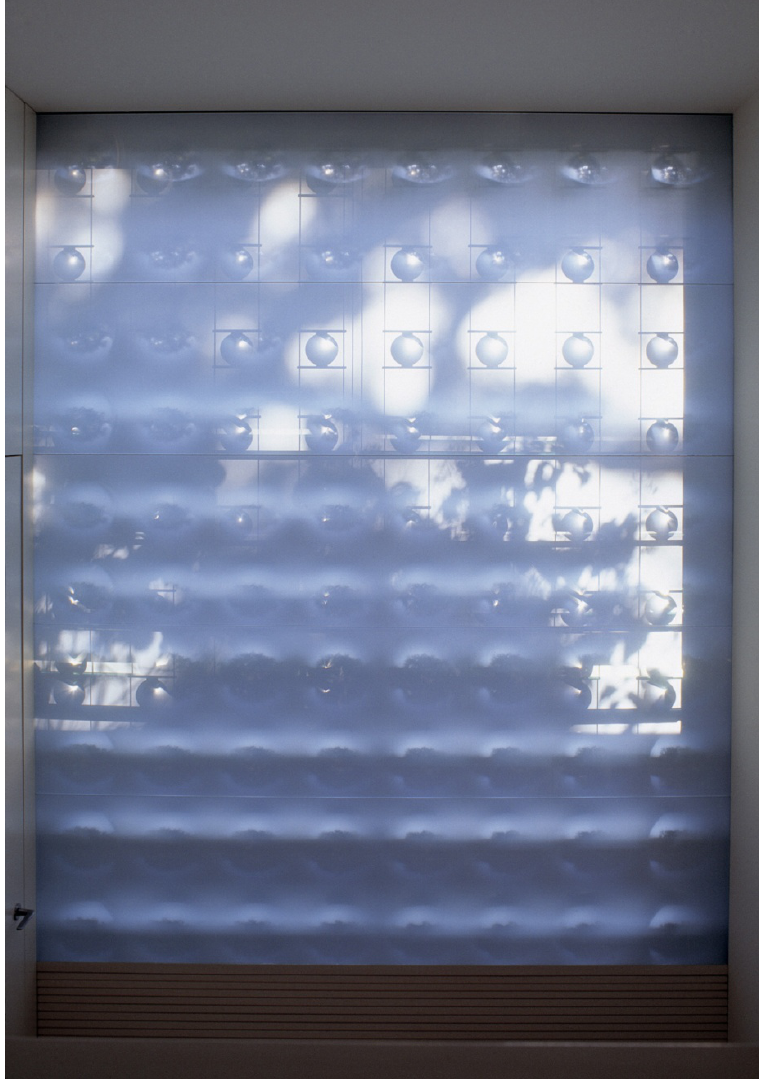
Figure 7: The Periscope Window seen presenting many types of projections, direct transmissions, cast shadows and